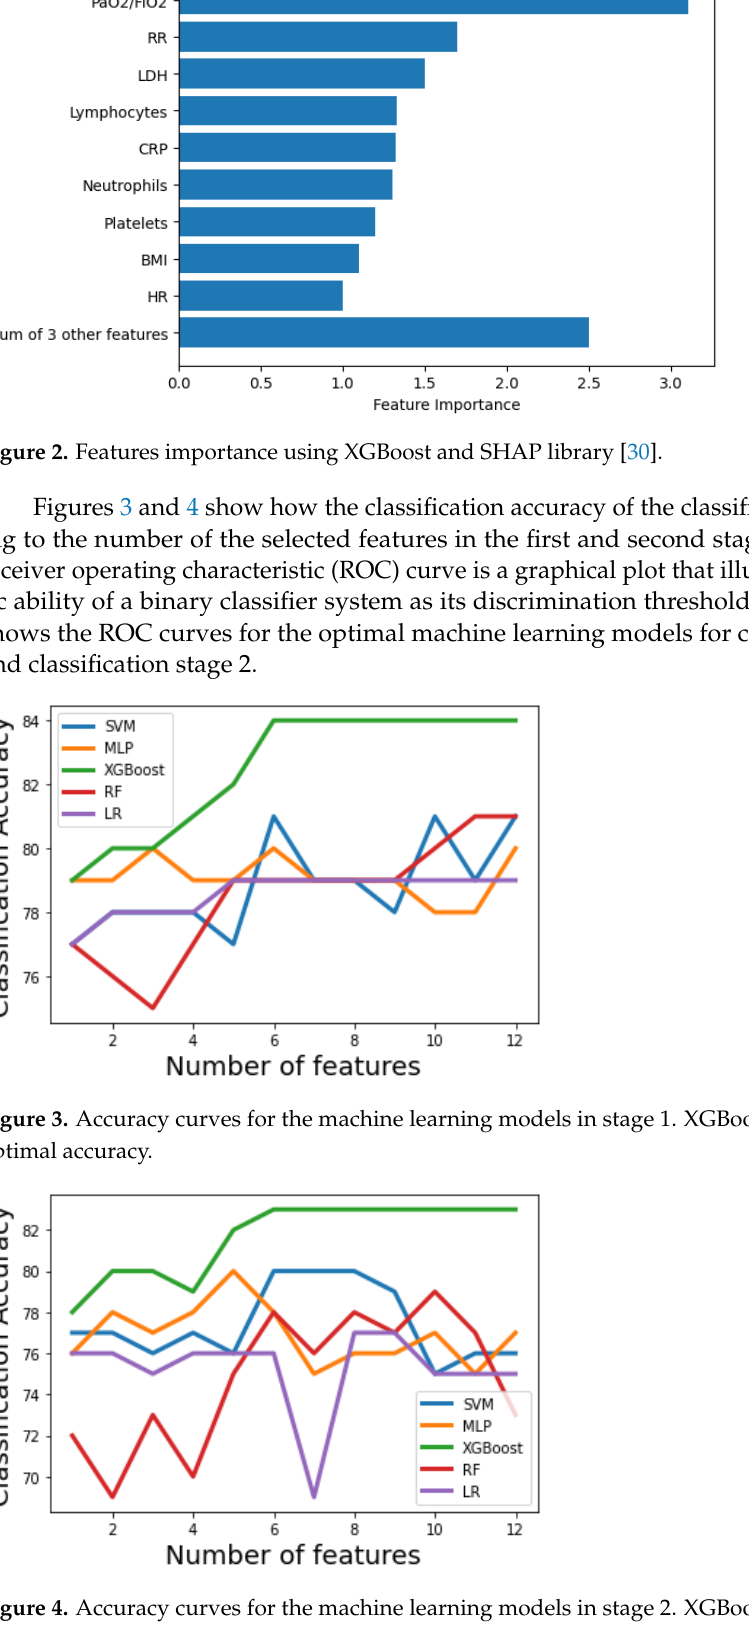
Figure 4. Accuracy curves for the machine learning models in stage 2. XGBoost classifier results in optimal